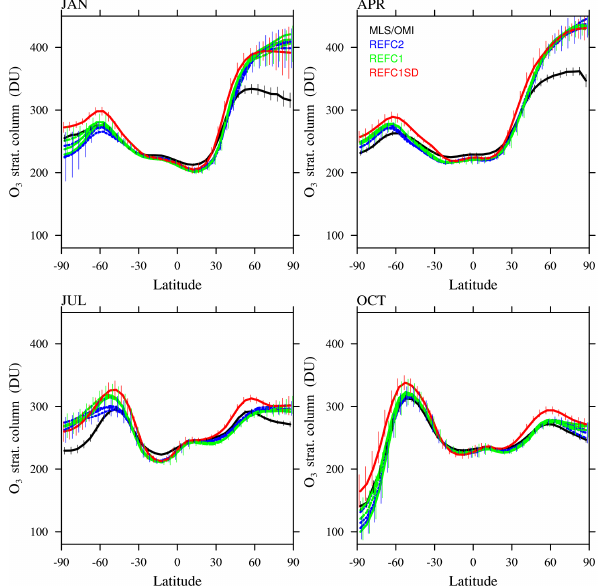
Figure 9. Monthly and zonally averaged tropospheric CO column comparison (in molec.cm − 2 ) between MOPITT satellite observa- tions (black) and different model experiments; see legend (for ozone < 150ppb in the model) for 4 months. Error bars for observations and model experiments show the standard deviation of the interan- nual variability per latitude interval.